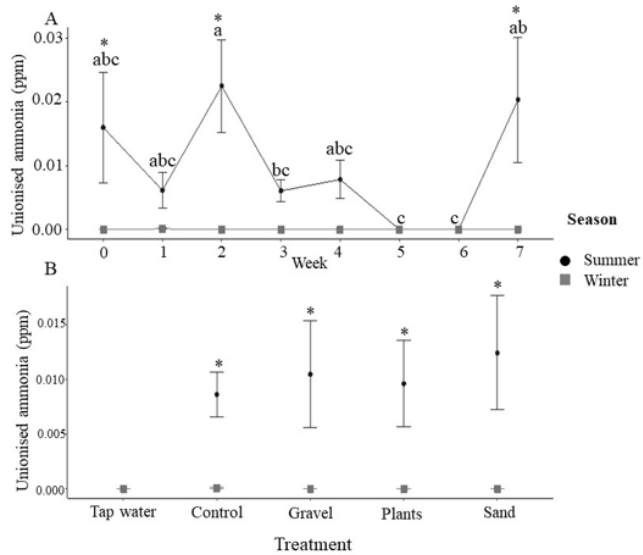
Animals 2022 , 12 , x 7 of 15 Figure 2. Tank concentrations of total ammonia nitrogen. ( A ) Tank total ammonia nitrogen (TAN;